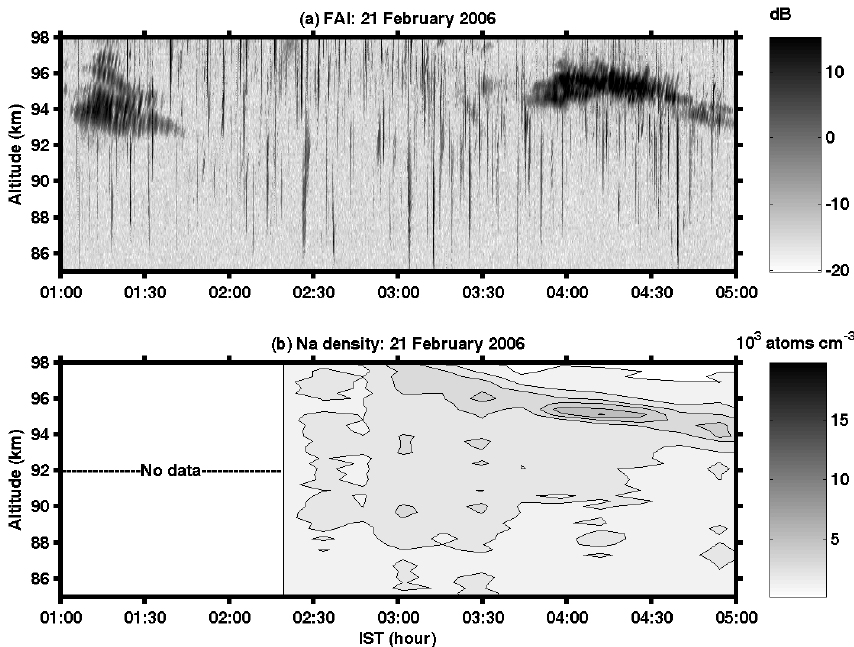
Fig. 3. Altitude-time cross section of intensity of echoes from FAI (top panel) and sodium density (bottom panel) for 21 February